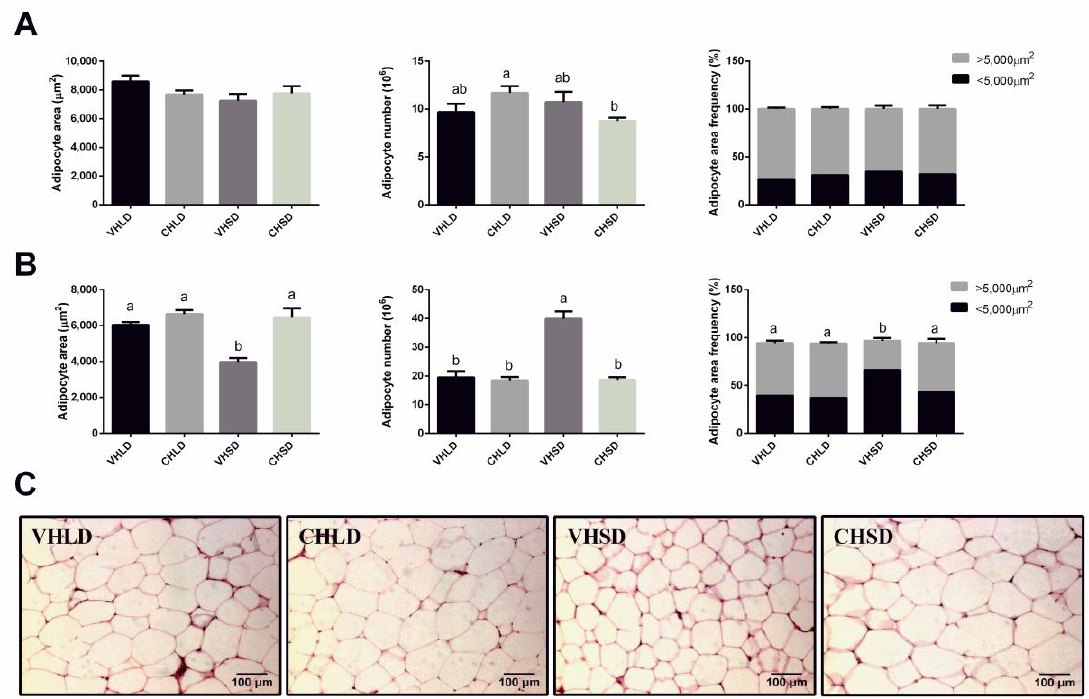
Figure 3. Adipocyte area, adipocyte total number, and adipocyte area frequencies of RWAT of Fischer 344 rats supplemented with a cherry (CH) lyophilizate or vehicle (VH), held in long-day (LD) and short-day (SD) photoperiods, and fed either with an STD ( A ) or a CAF ( B ) diet in two independent experiments. Representative pictures of all the CAF groups are shown ( C ). For frequencies, adipocytes were distributed into two groups depending on their areas (<5000 or >5000 µ m 2 ). Data are presented as the mean ± SEM, and the four groups were compared with a one-way ANOVA test ( p < 0.05) followed by a Duncan’s new multiple range test (MRT) post hoc test. ab Mean values with unlike letters differ significantly among groups.